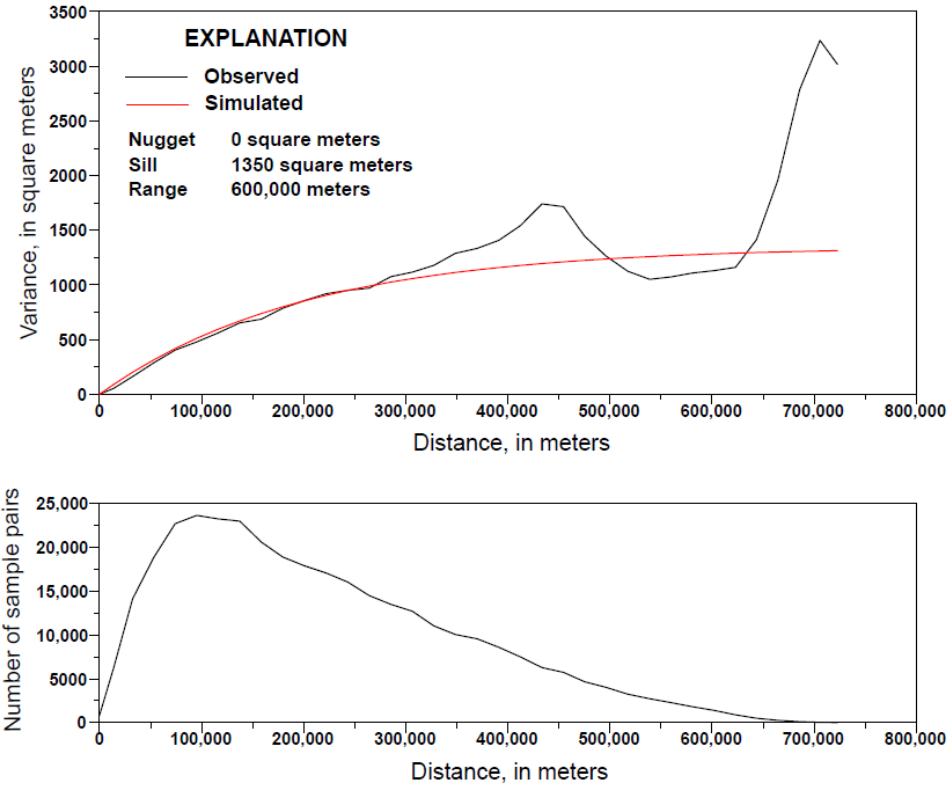
Figure 5. Variogram showing the correlation between the variance of all paired data values and the spatial distance between those paired values for the observed (black line in top panel) and simulated (variogram model; red line in top panel) water-level altitude data as well as the number of sampled value pairs compared to distance between paired values (black line in bottom panel). The nugget describes the small-scale variability of the data over short distances [42]. The sill describes the maximum variability between point pairs and the range describes the distance at which point pairs are no longer spatially correlated [41,43].